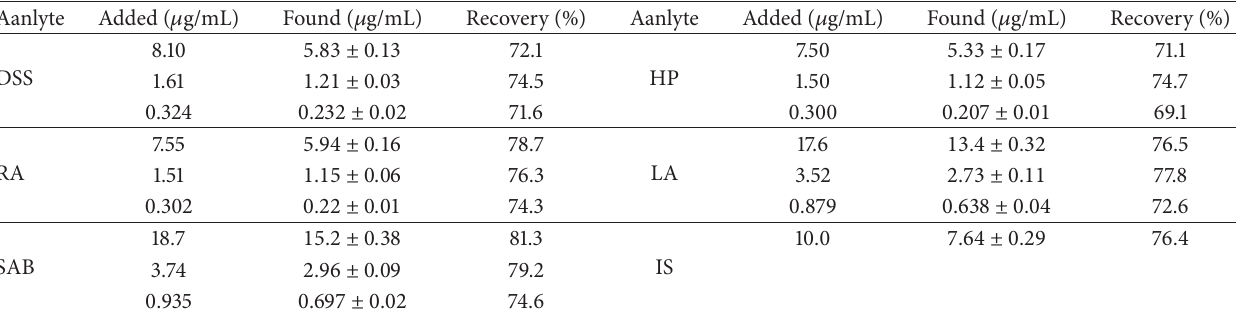
Table 3: Recoveries of SAB, RA, LA, DSS, and HP ( 𝑛 = 3 ). Aanlyte Added ( 𝜇 g/mL)